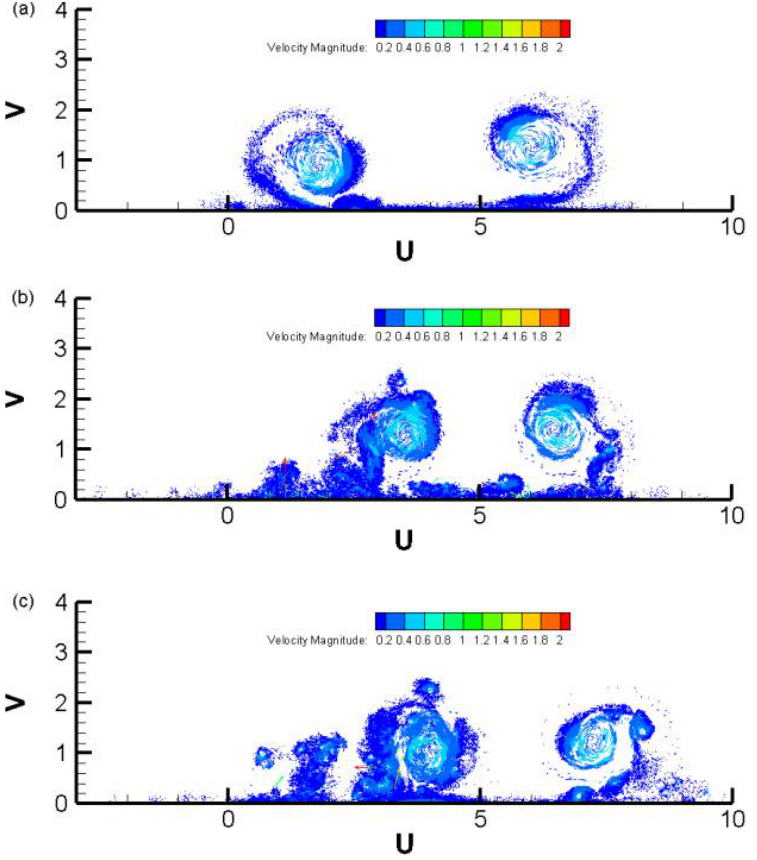
Figure 12. Instantaneous velocity field behaviors with combined effects of buoyancy and different crosswind magnitudes (Ri = 1.018, T ∞ * = 20 ◦ C, T W * = 40 ◦ C, Pr = 0.7, and Re = 7650): ( a ) t = 50.00 and U ∞ = 0.0; ( b ) t = 50.00 and U ∞ = 0.02; and ( c ) t = 50.00 and U ∞ = 0.04.